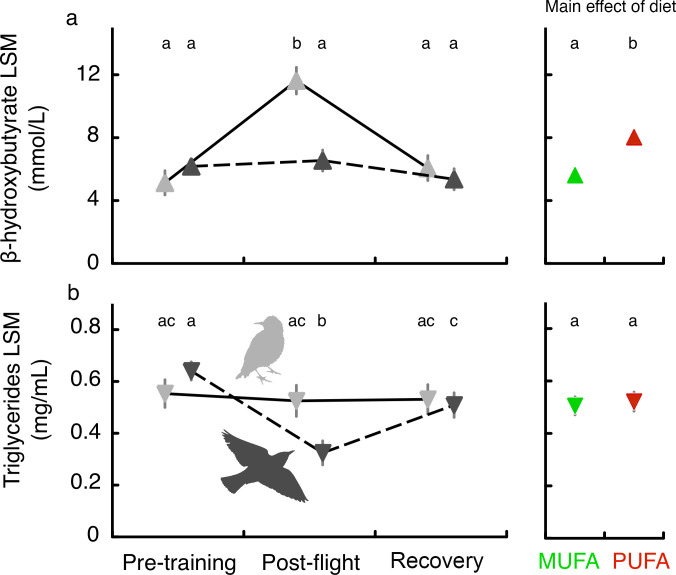
Plasma metabolites of European starlings associated with flight-training and in relation to diet quality.Change in circulating levels of (a) Beta-hydroxybutyrate, and (b) Triglycerides in plasma of European starlings over the 15-day flight-training for Trained birds (dark triangles and dashed lines) and over the same 15-day period for Sedentary birds that were not flight-trained (gray triangles, solid lines) in Experiment II. Plasma samples were collected in the early morning after an overnight without food on Day O (Pre-training), before the start of flight-training, on Day 15 immediately after the birds longest flight (Post-flight), and in the early morning after an overnight without food on Day 17 (1.5 days after recovery from the last flight). Body mass and date of measurement were included as a fixed covariate so that we report the results as least square means (LSM). Comparisons between Pre-training and Recovery indicate changes associated with the 15-day flight-training, whereas those between Recovery and Post-flight indicate changes associated with the longest flight on Day 15. Means with different letters across the three timepoints, and for the main effect of diet, are significantly different (p<0.05).